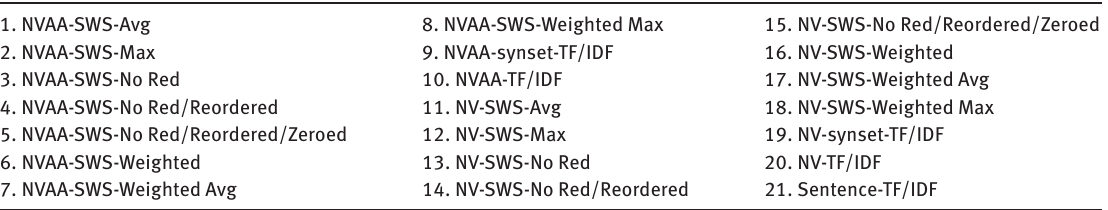
Table 2: Legend for the 21 Measures Shown in Figures 2–7.